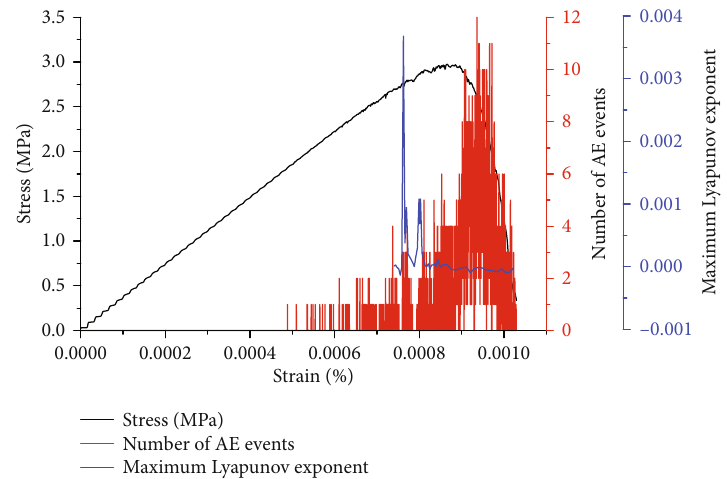
Figure 8: Stress-strain-number of AE events-maximum Lyapunov exponential variation diagram of specimen 5.